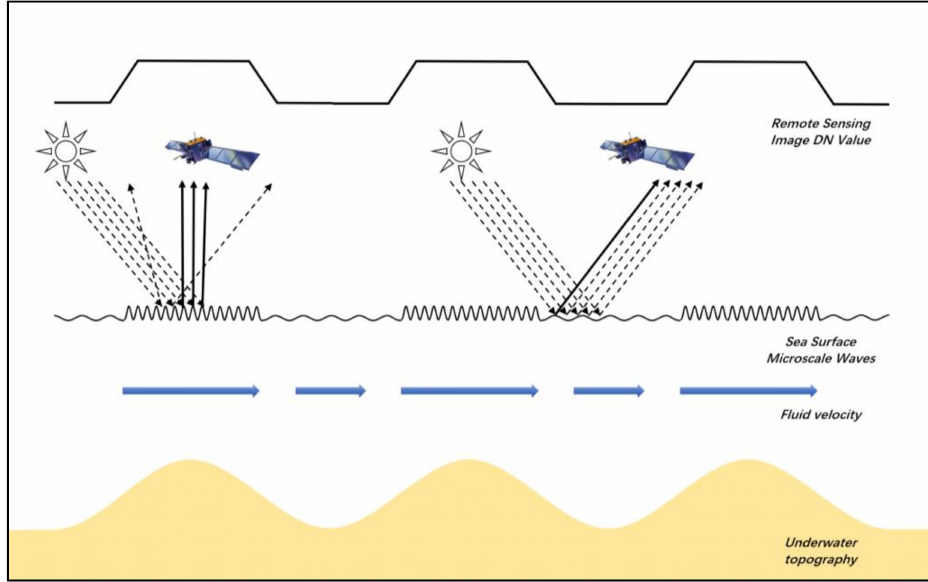
Figure 5. Imaging principle of underwater topography in the deep or turbid